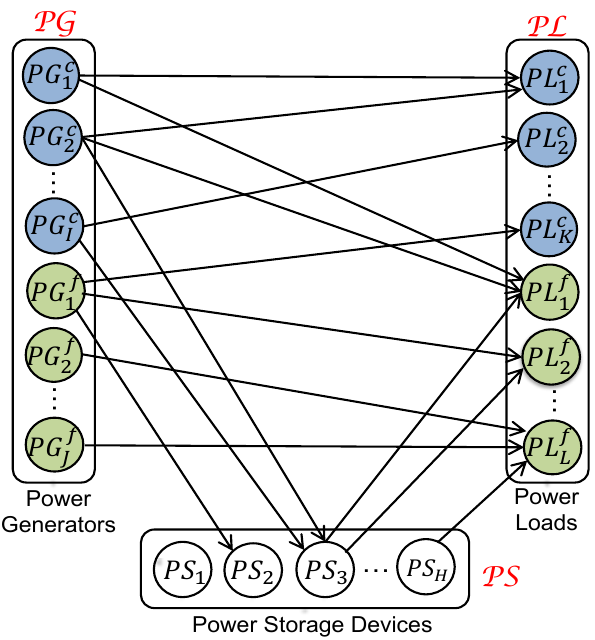
Figure 1. Presentation of power generators, power loads, power storage devices, and connections between power